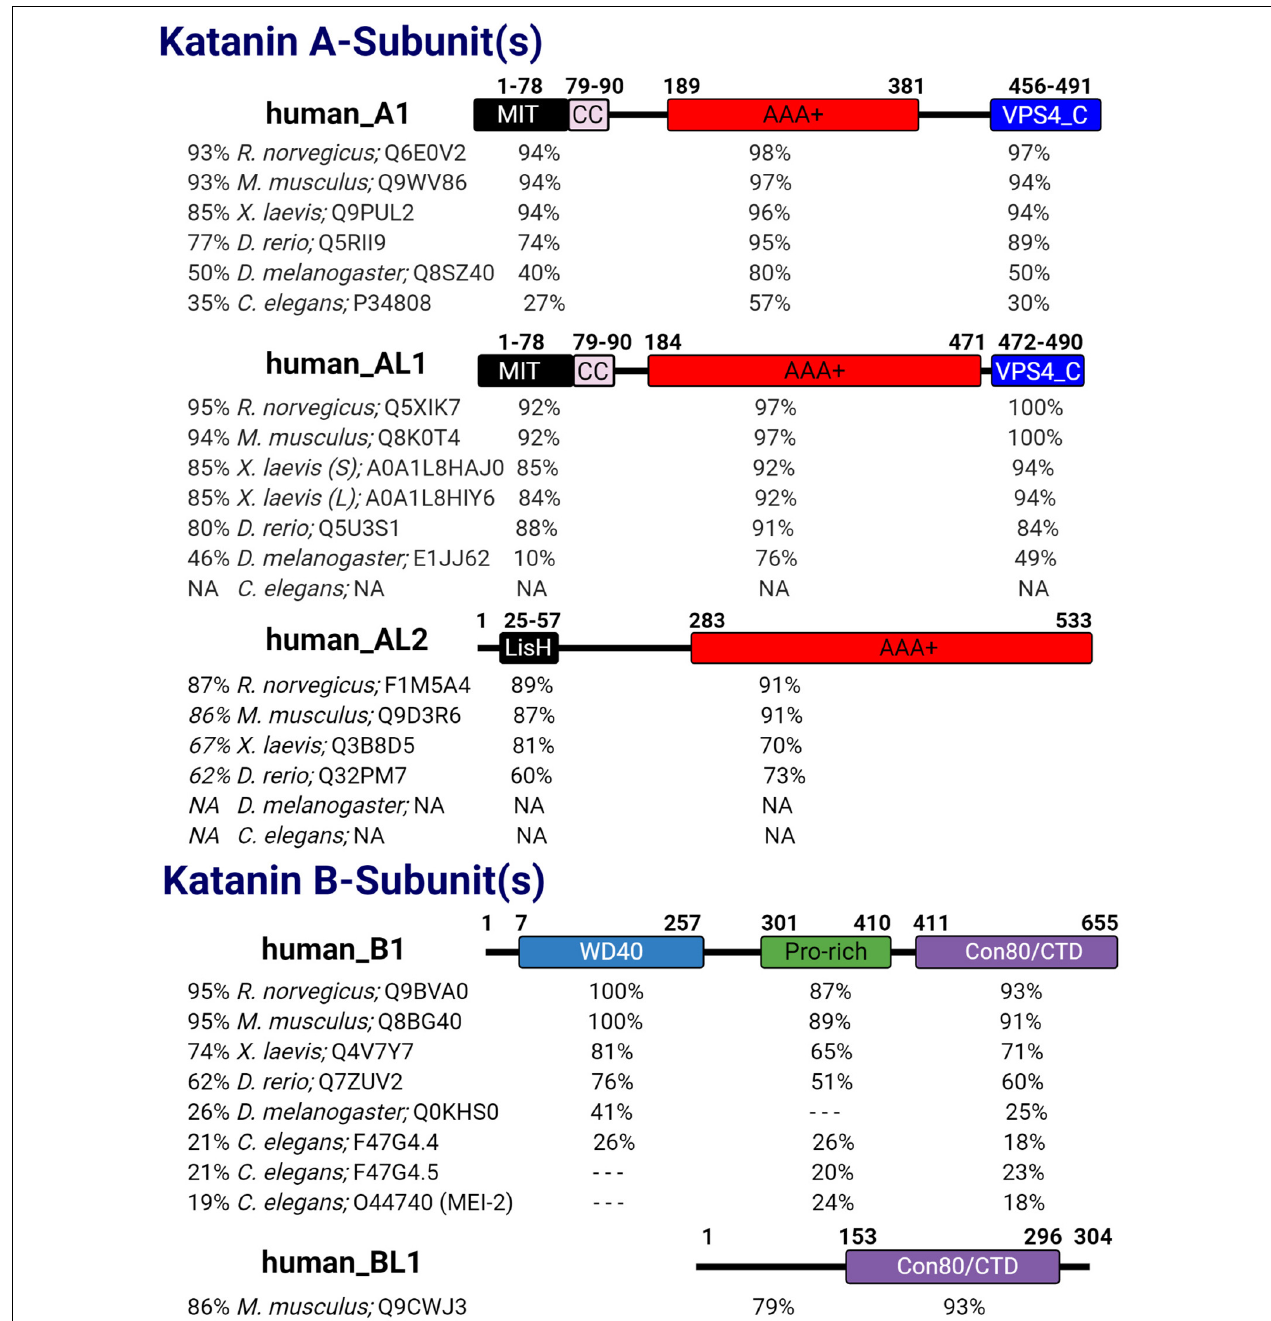
FIGURE 1 | Katanin subunit conservation. The five human katanin subunits—A1 (UniProt ID: O75449), AL1 (UniProt ID: Q9BW62), AL2 (UniProt ID: Q8IYT4), B1 (UniProt ID: Q9BVA0), and BL1 [UniProt ID: Q9H079 (human)]—and their corresponding domains are displayed. For each human katanin subunit, the relative percent identity to full-length (FL) and to each domain therein is indicated for its orthologs in other organisms. Percent identity was determined using NCBI protein blast with BLOSUM62 matrix. Dashed lines indicate no percent identity for that region; N/A indicates that the species lacks that homolog. For Xenopus laevis AL1, S and L indicate short and long isoforms, respectively. For Caenorhabditis elegans B1 homologs F47G4.4 and F47G4.5 are WormBase IDs and a UniProt ID was used for